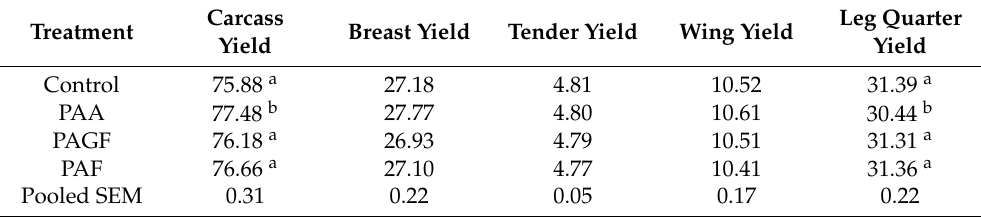
Table 4. Processing yield averages (%) of broilers fed either a control diet or control diet with 5 mg/bird/day of phosphatidic acid added from d0–42 (PAA), d15–42 (PAGF), d29–42 (PAF). Carcass Treatment